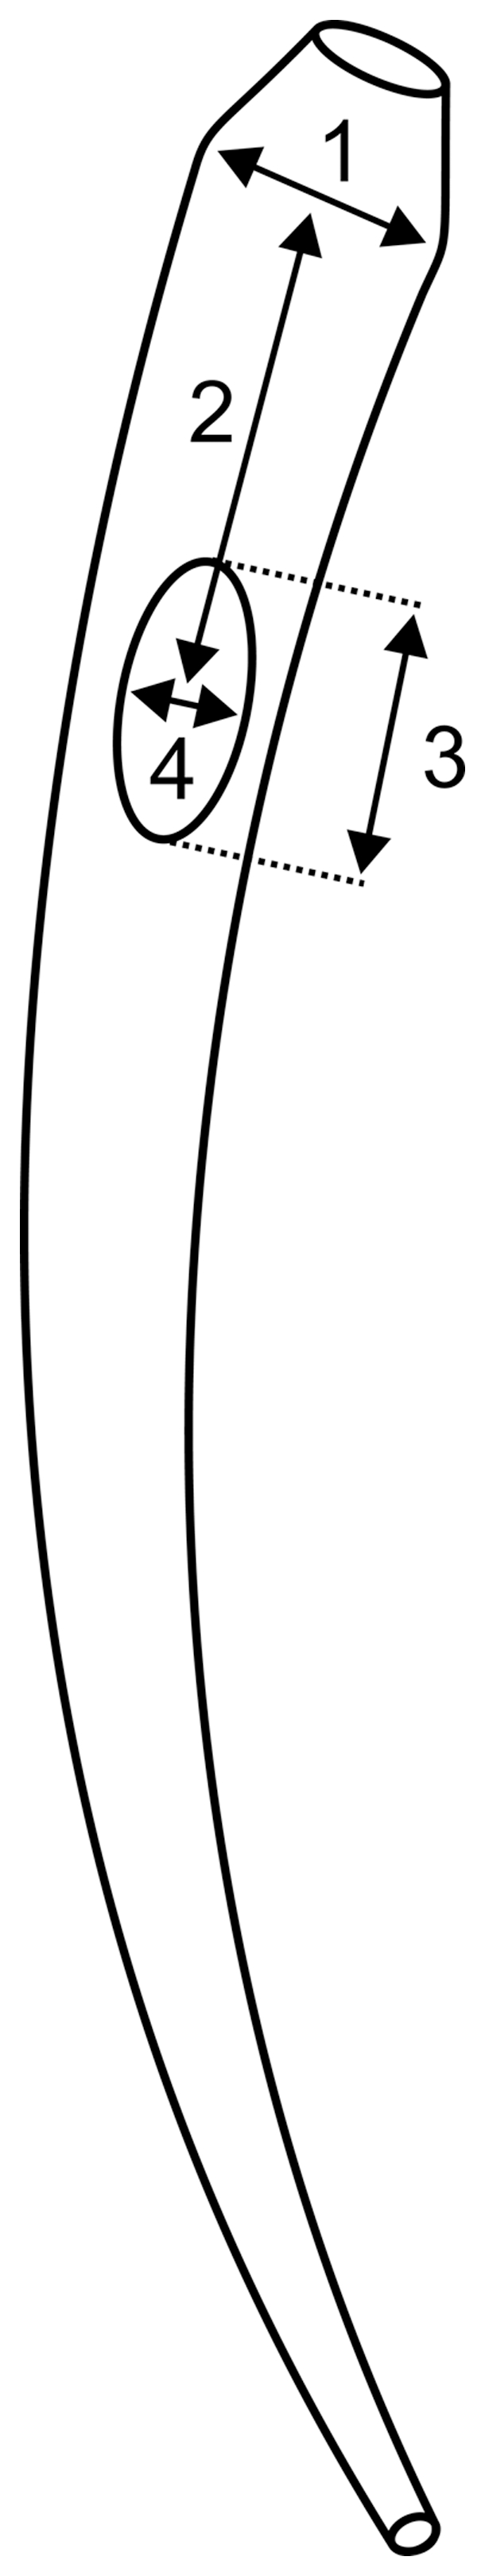
A schematic summary of biometric measurements used in this study for Ditrupa tubes and tube fragments.(1) Maximum tube diameter; (2) Relative drillhole location; (3) Maximum drillhole diameter; (4) Minimum drillhole diameter.